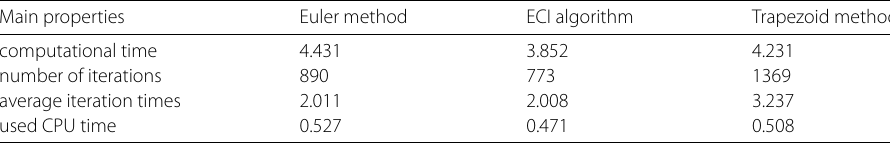
Table 3 Comparison of various characteristics for different methods Main